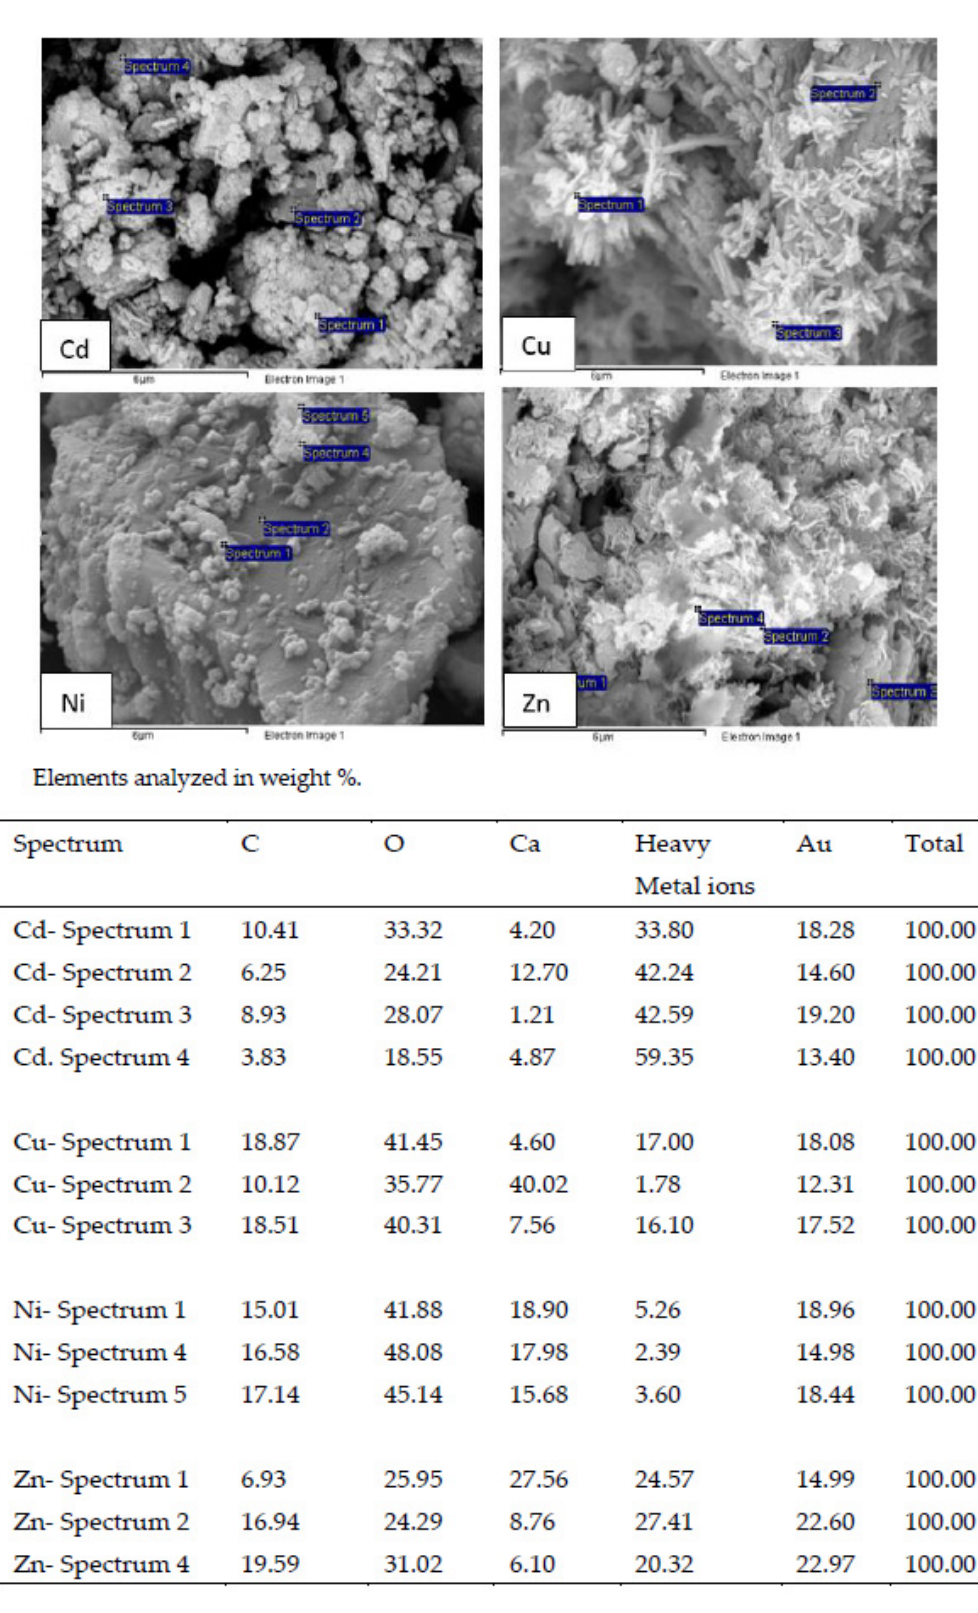
Figure 7. Scanning electron micrograph and EDX analysis of WS after the treatment of the leachate using an adsorbent concentration of 0.4 g L − 1 .